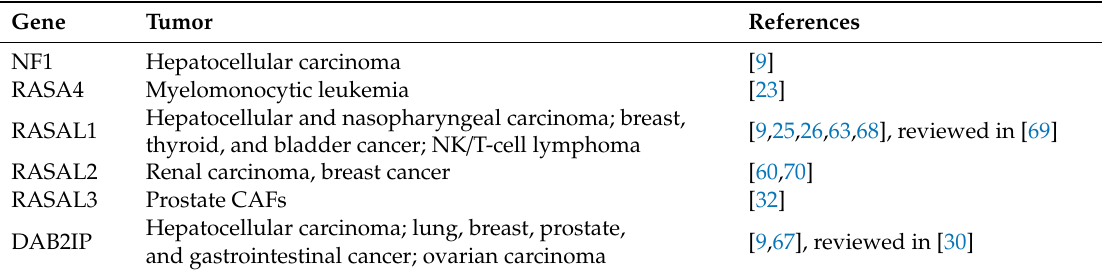
Table 1. Evidence of promoter methylation of RasGAPs in cancer.